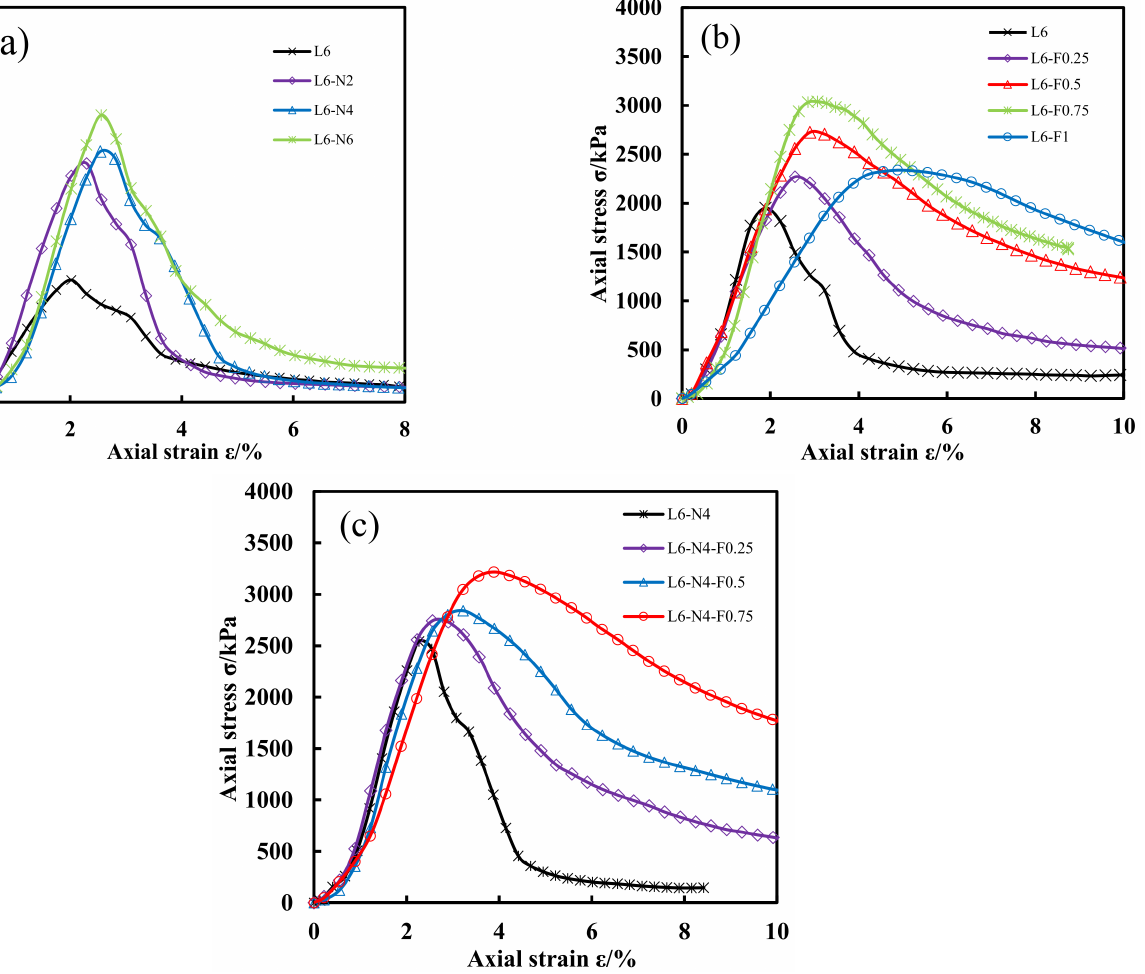
Figure 6. Stress-strain curves of UCS tests. ( a ) NLS with different nano clay content; ( b ) FLS with different fiber content; ( c ) NFLS with 4% nano clay content and different fiber